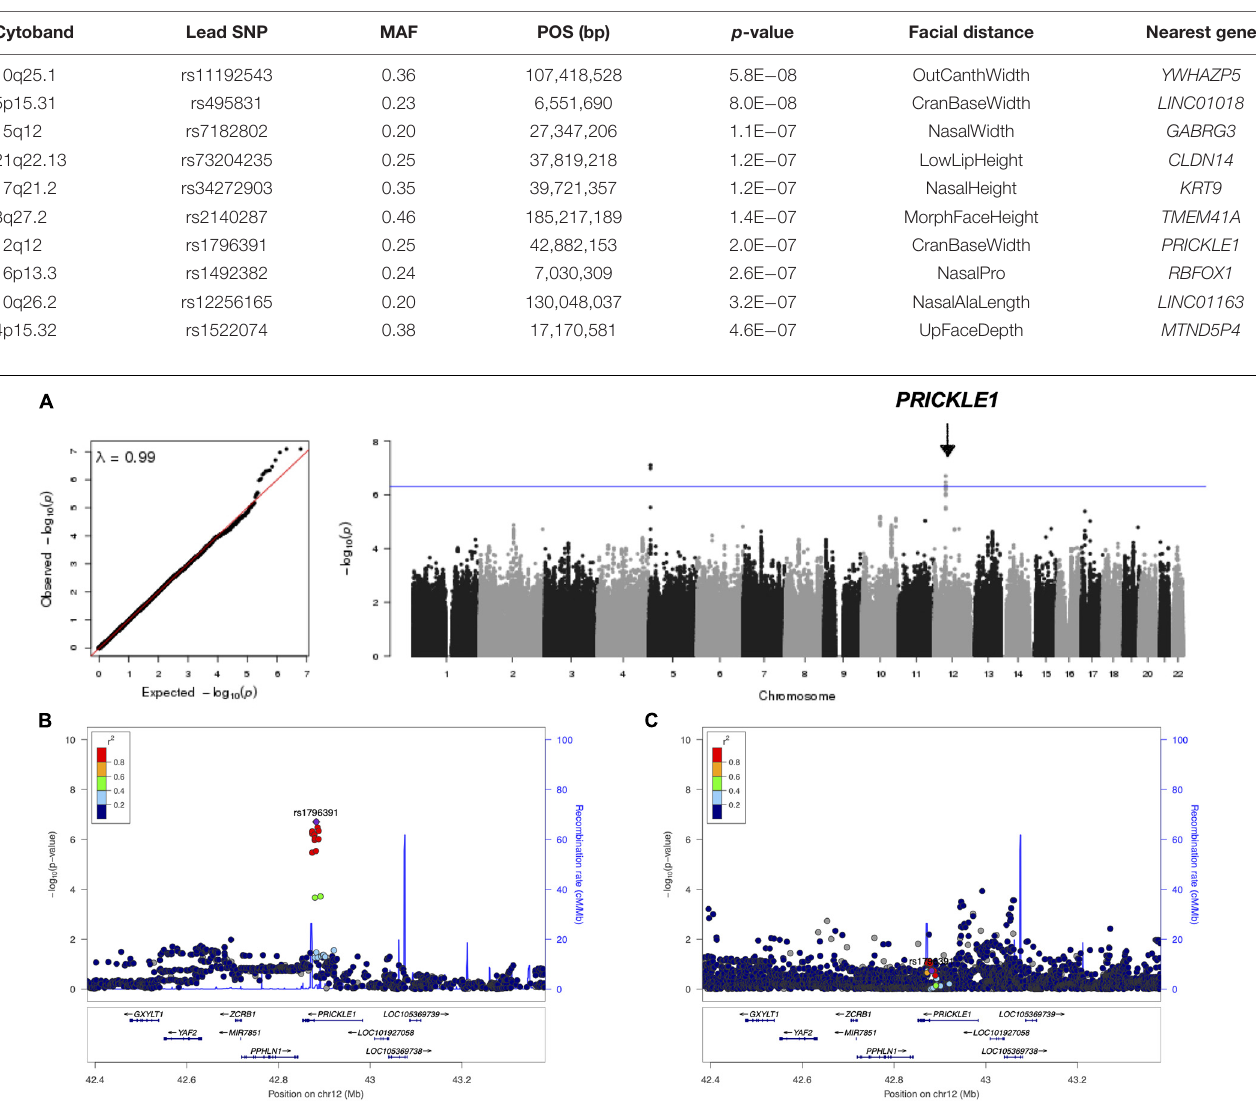
TABLE 1 | Suggestive variance quantitative trait loci (vQTLs) of facial features ( p < 5 × 10 − 7 ). Cytoband Lead SNP MAF POS (bp) p -value Facial distance Nearest gene 10q25.1